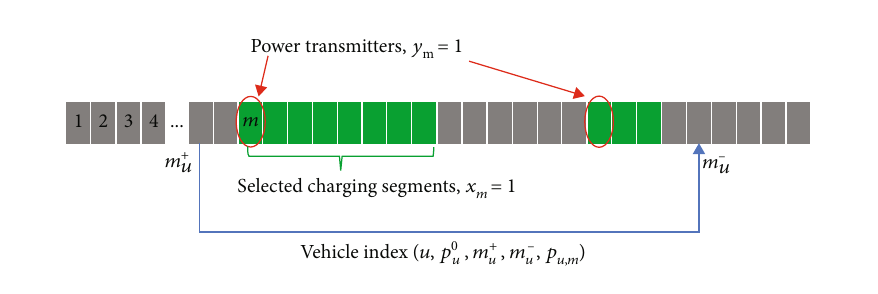
Figure 3: DWC lane infrastructure